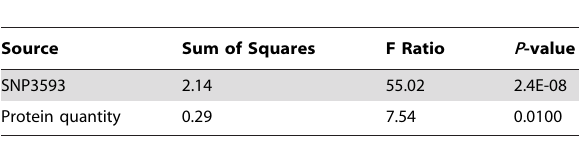
Table 5. Two-way ANOVA of IDH enzyme